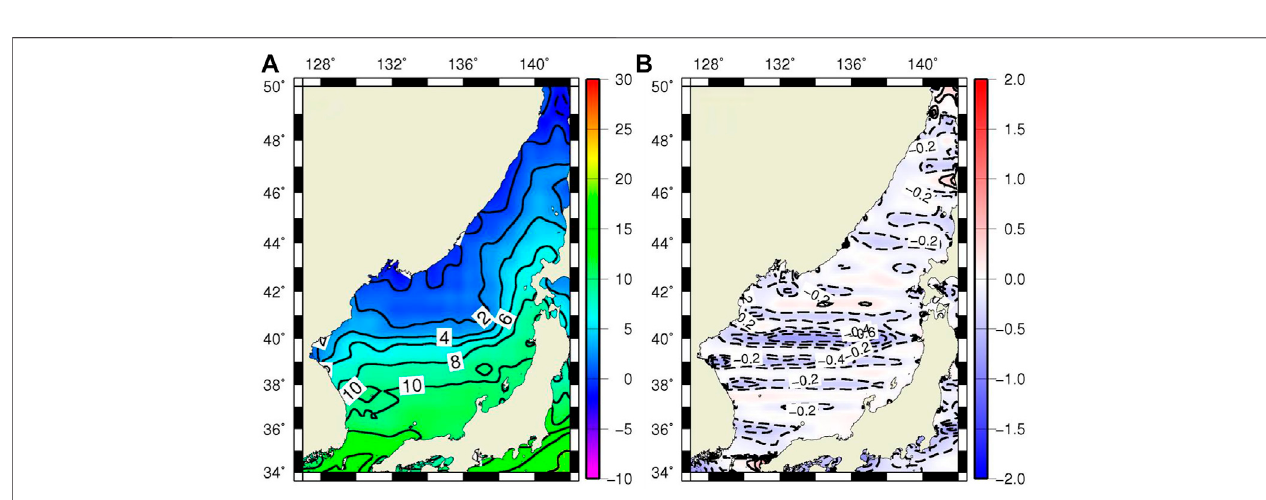
FIGURE 2 | (A) Horizontal temperature distribution and (B) meridional temperature gradient at the surface of EASRC in February.